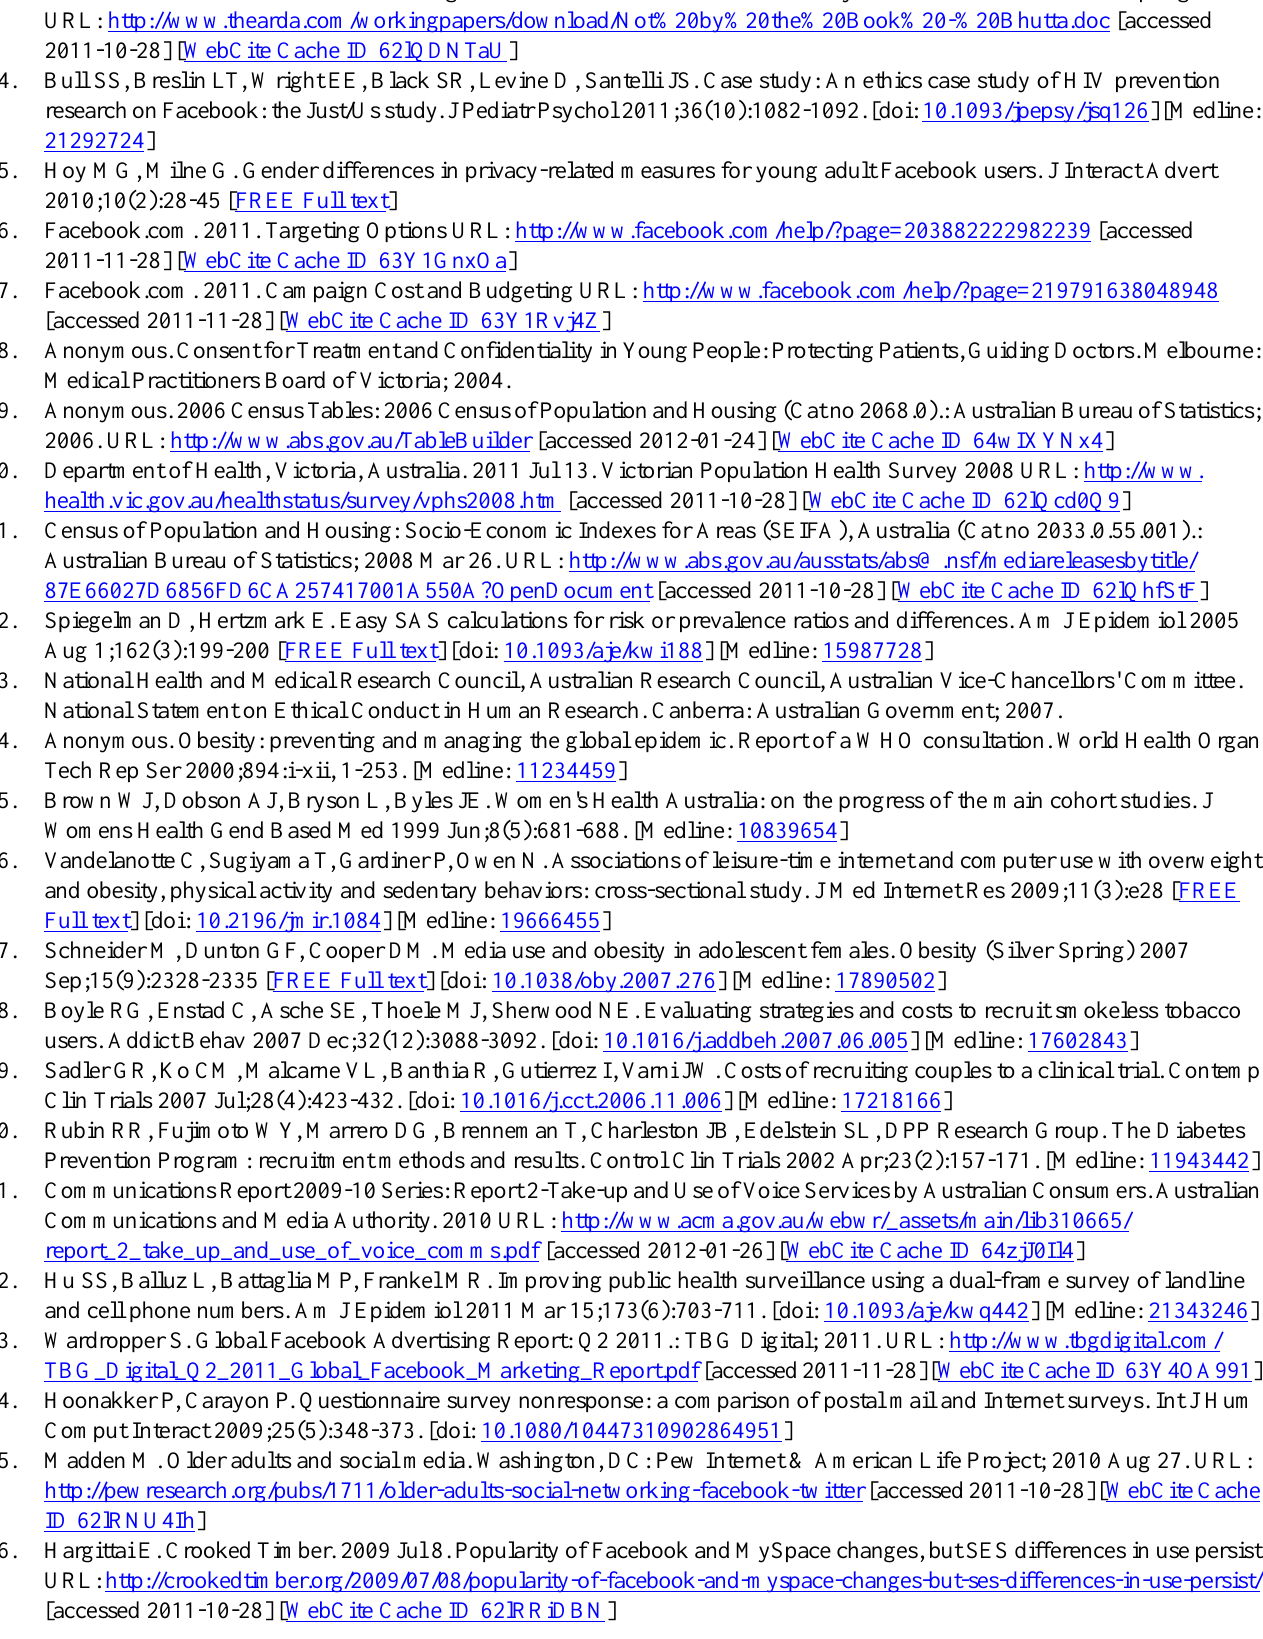
Abbreviations ALSWH: Australian Longitudinal Study on Women’s